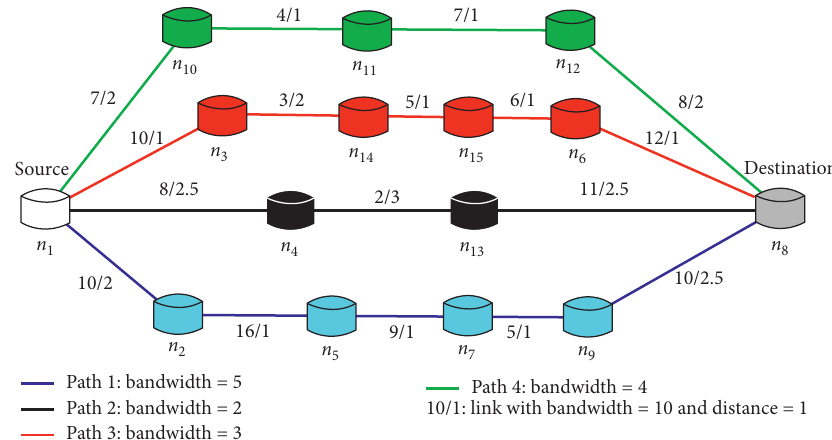
Figure 5: Graph with different bandwidth